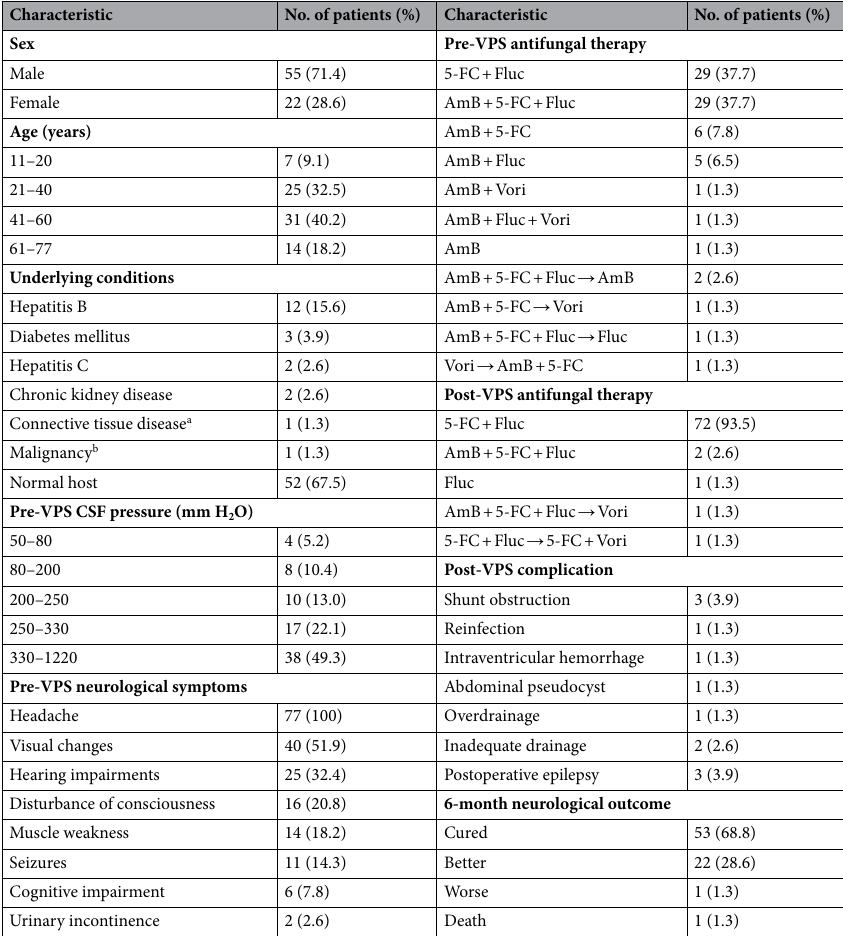
Table 1. Demographic and clinical features of patients. Data presented as n (%). AmB = amphotericin B; 5-FC = flucytosine; Fluc = fluconazole; Vori = voriconazole; NA = not applicable; + : combined with; → : changed to; a systemic lupus erythematosus; b multiple